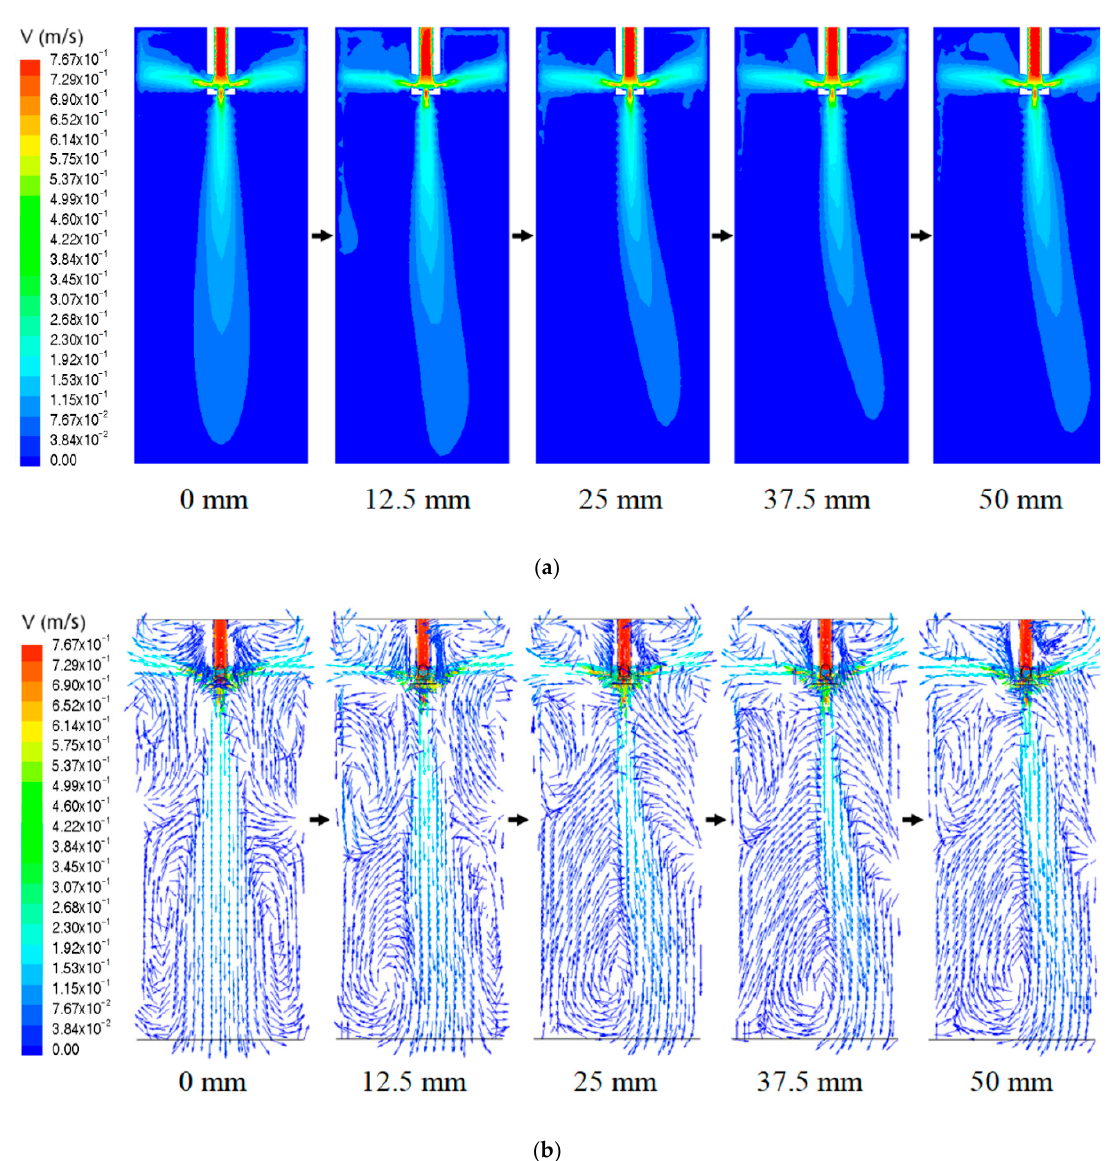
Figure 5. Flow fields of molten steel of the SEN with different eccentric distances. ( a ) Contour; ( b ) Vector graph.